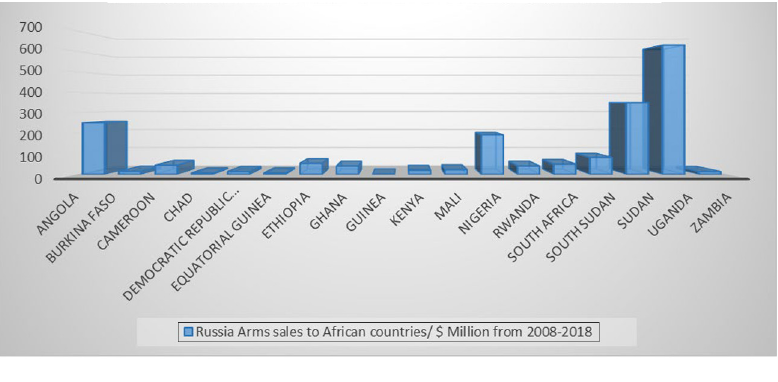
Figure 4. Russia arms sales to African